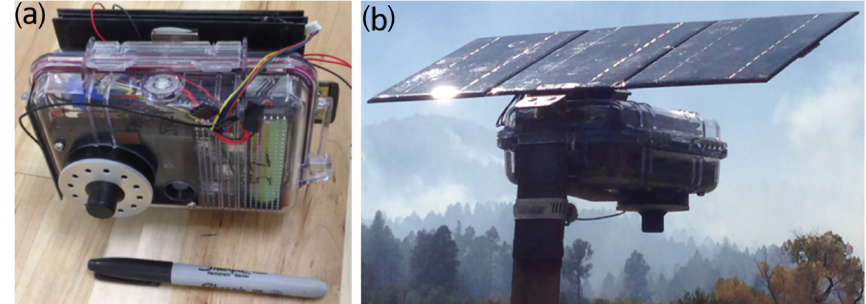
Figure 1. OAS sampler in (a) transportation configuration and (b) deployment